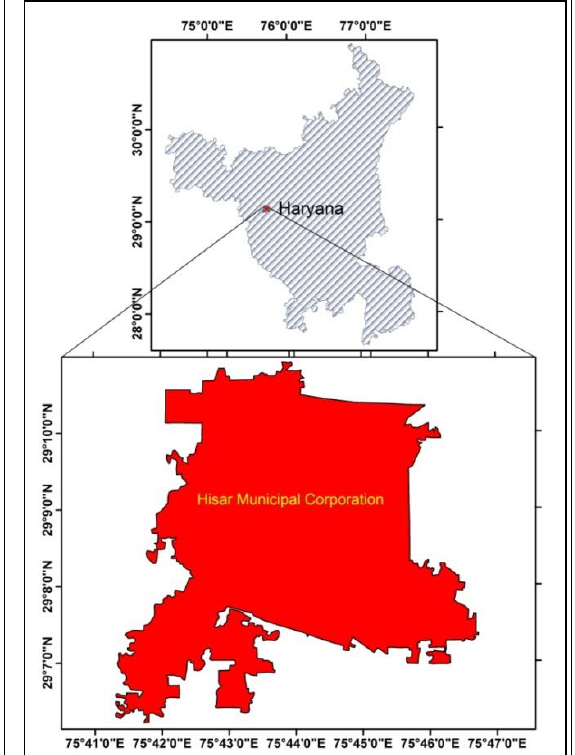
Figure 1: Study Area showing Hisar Municipal Corporation boundary and its location in Haryana 2.2.1 Data Use